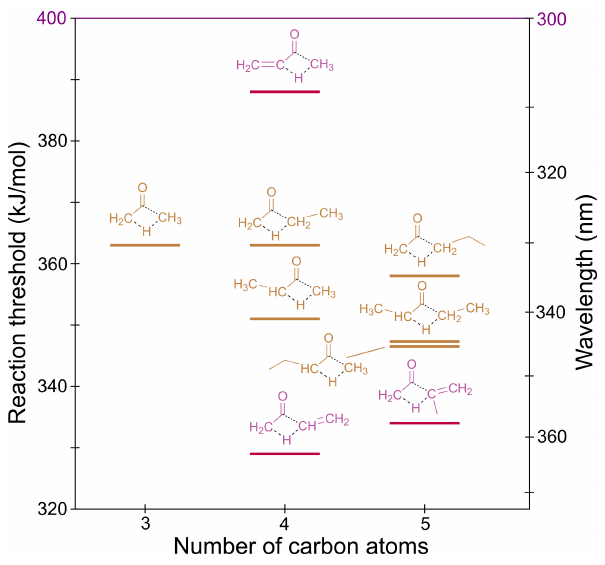
Figure 8. Zero-point vibrational-energy-corrected B2GP-PLYP- D3/def2-TZVP S 0 alkane/alkene elimination thresholds.